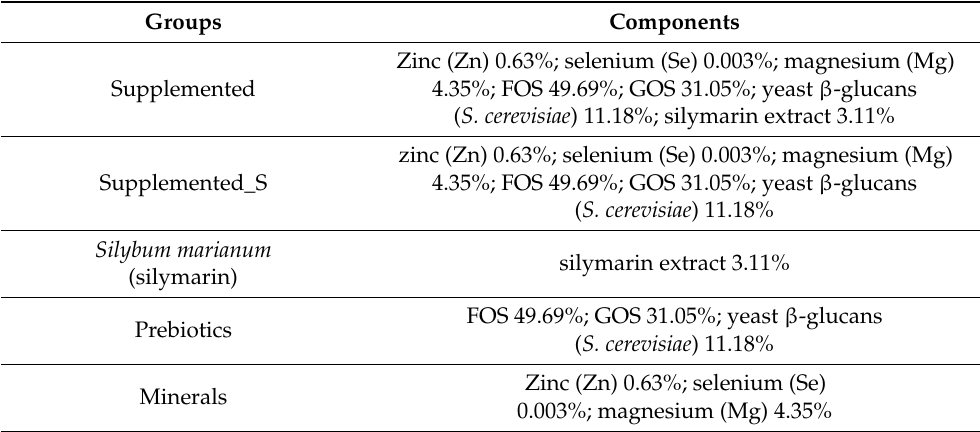
Table 1. Specific supplement composition described by experimental group.